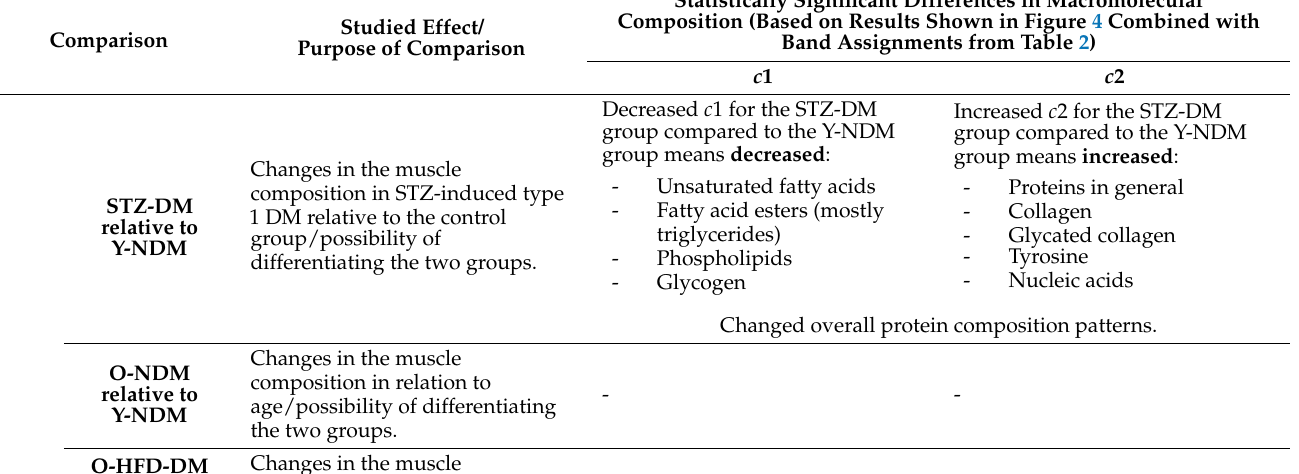
Table 3. Summary of statistically significant differences in muscle composition between 13-week-old non-diabetic mice ( n = 9) (Y-NDM), 13-week-old STZ-induced diabetic mice ( n = 9) (Y-STZ-DM), 54-week-old non-diabetic mice ( n = 9) (O-NDM), and 54-week-old HFD-induced obese insulin- resistant mice ( n = 9) (O-HFD-DM), and statistically significant differences in muscle composition between gluteus maximus and gastrocnemius muscles within each group at the 0.05 significance level based on the results shown in Figure 4 combined with the band assignments from Table